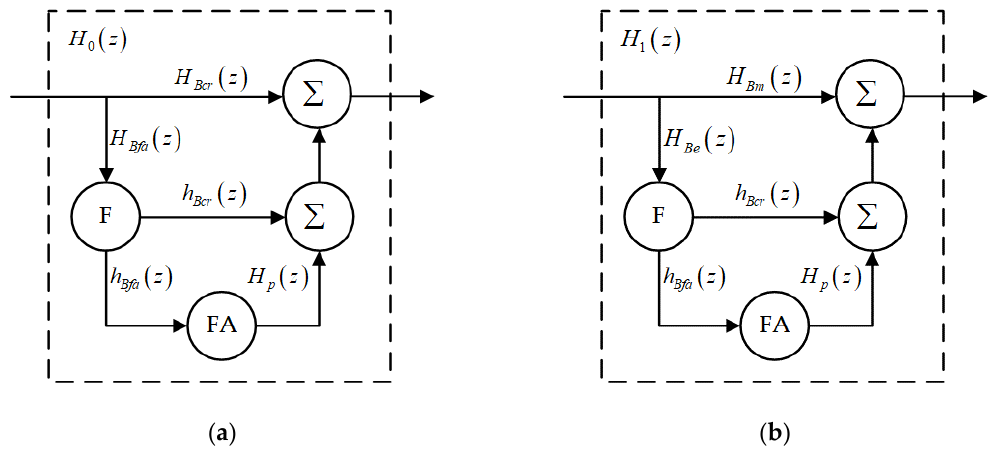
Figure 9. ( a ) Transfer function between two H0-blocks; ( b ) Transfer function from H1-block to H0- block.